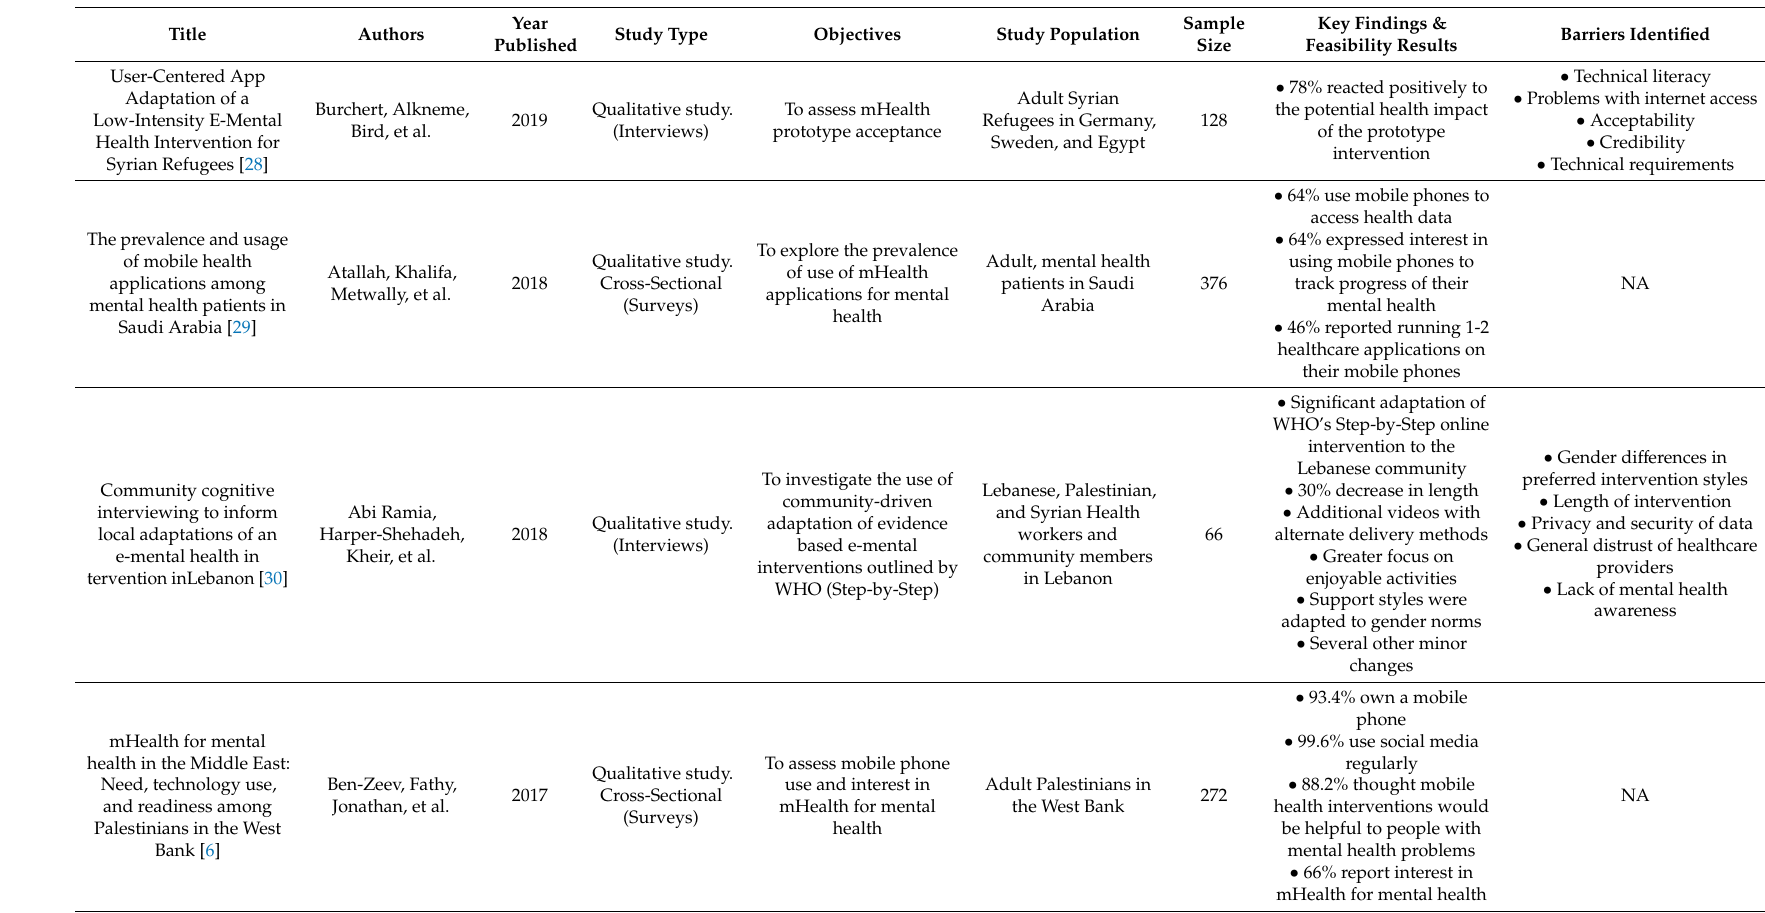
Table 3. Background Information and Key Findings of Included